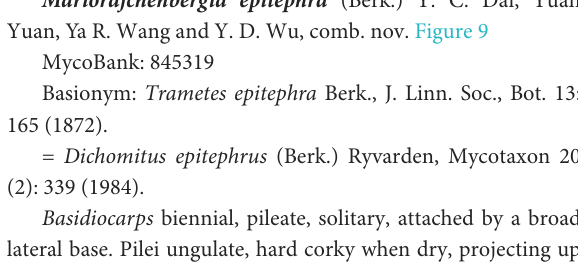
thin-walled, smooth, 23–28 × 6.5–15 µ m. Basidia